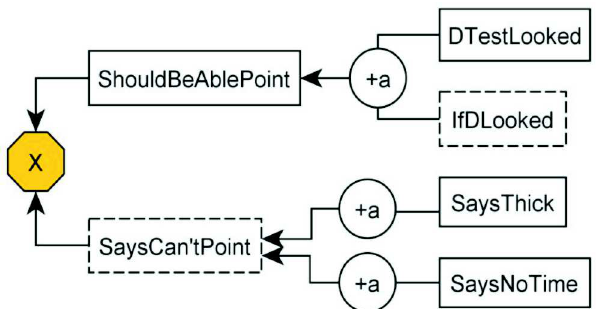
Figure 4. Conflict Diagram of the Second Part of the Expert Opinion